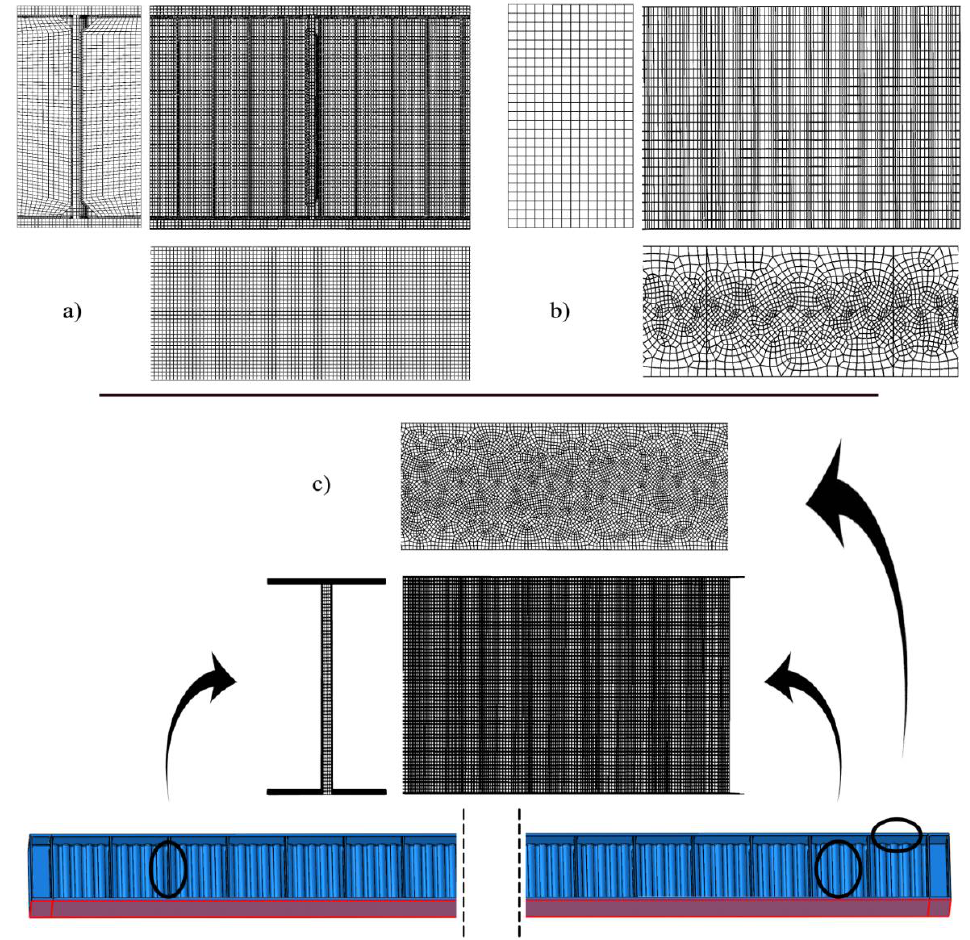
Figure 6. ABAQUS discretization of the girder, ( a ) with ribs and welds (volumetric, model 1), ( b ) with ribs (shell, model 2), ( c ) without ribs (shell, model 3). ribs (shell, model 2), ( c ) without ribs (shell, model